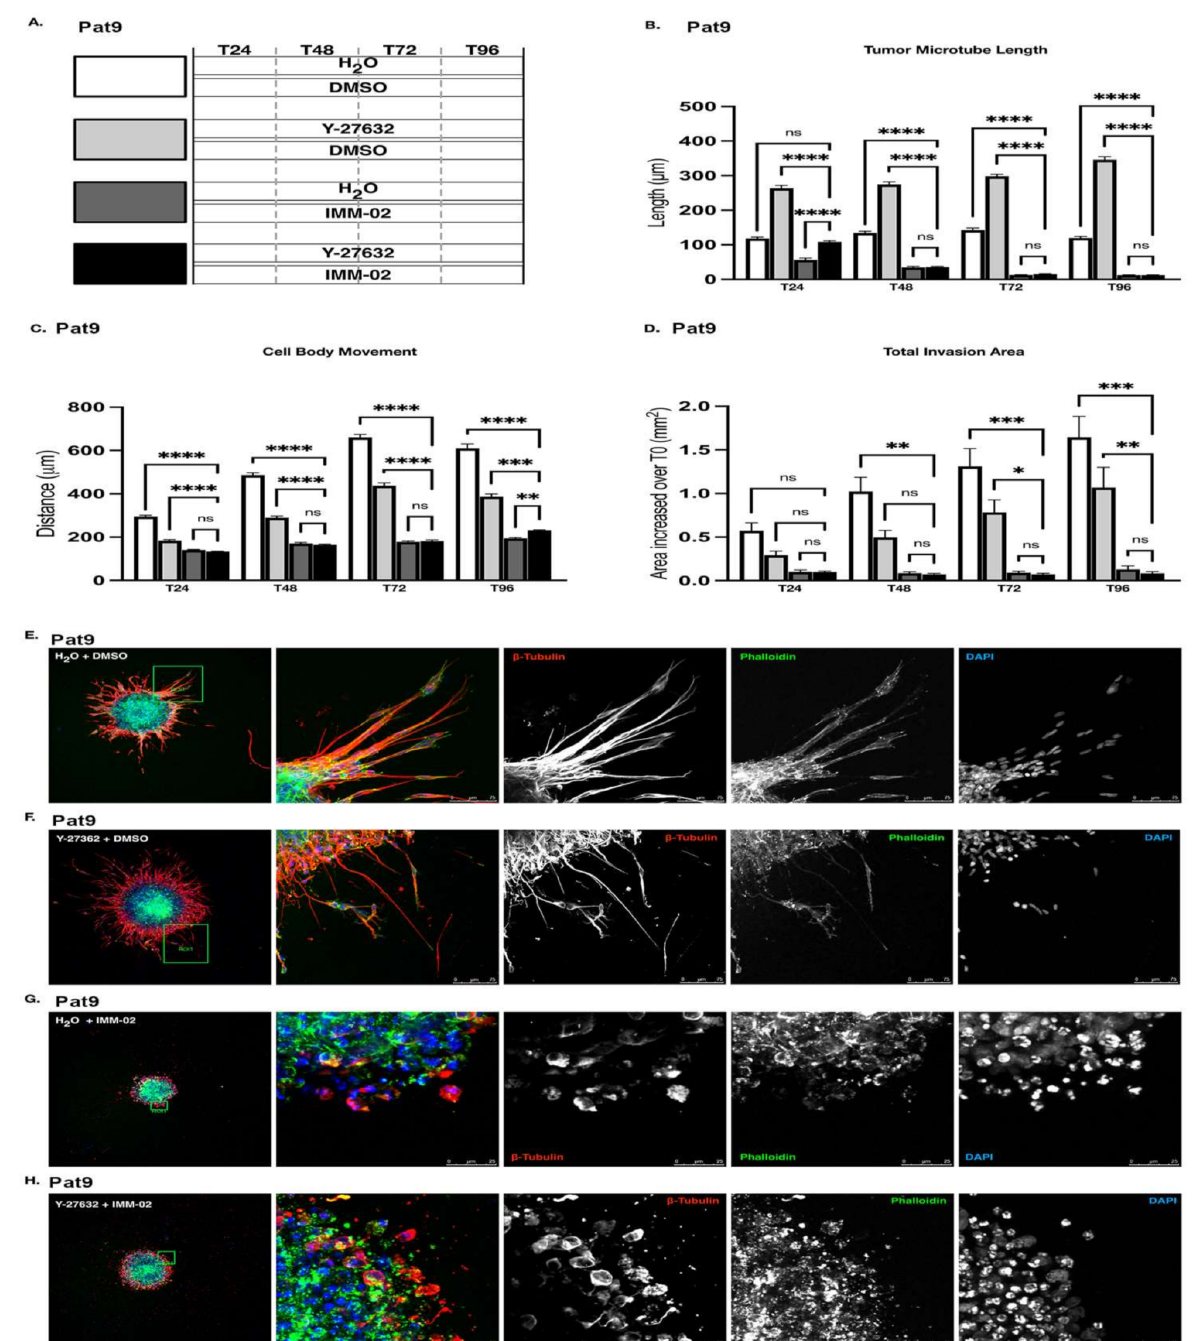
Figure 3. Combined targeting of ROCK and mDia halts GBM patient-derived sphere invasion, yet is not superior to mDia formin agonism alone. ( A ) Schematic of drug exposures in combination drug 3D invasion assays (Y-27632 = 90 µ M; IMM02 = 50 µ M). Bars at left indicate 48 h invasion prior to indicated drug treatment. ( B ) Tumor microtubule length in indicated Pat9 96 h 3D invasion assays. **** p ≤ 0.0001; ns = not significant. ( C ) Distance of cell body movement from the neurosphere core in indicated Pat9 96 h 3D invasion assays. ** p ≤ 0.01; *** p ≤ 0.001, **** p ≤ 0.0001. ( D ) Increase in total area of invasion over T0 in indicated Pat9 96 h 3D invasion assays. *** p ≤ 0.001; ** p ≤ 0.01; * p ≤